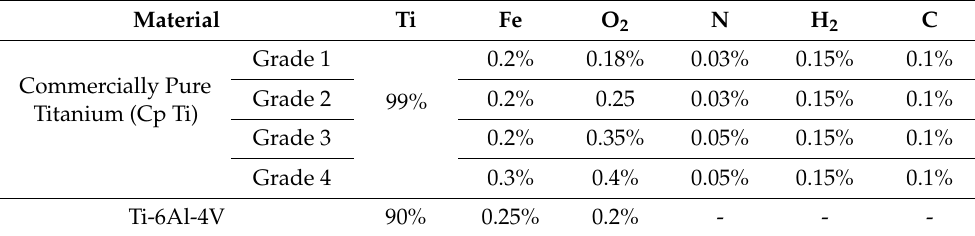
Table 6. Commonly used titanium alloy chemical compositions